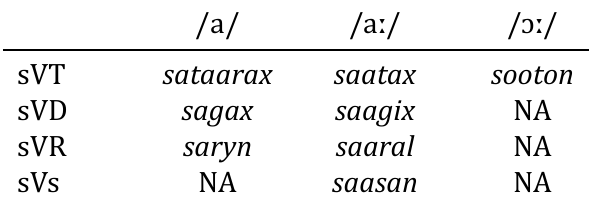
Table A.5: C₁ /s/ in polysyllables